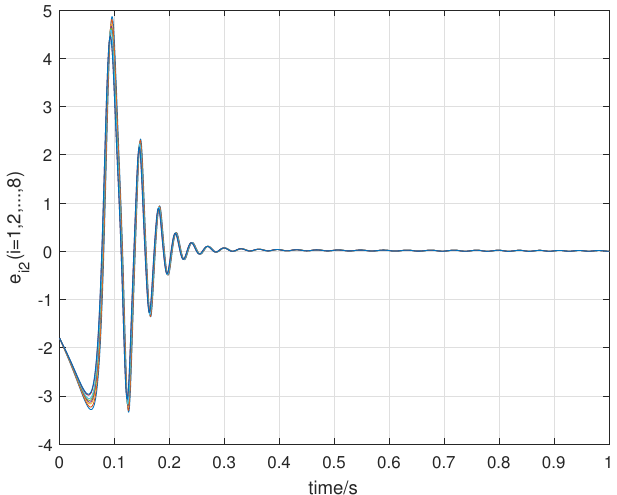
Figure 3. Trajectories of synchronization errors e j 2 ( 1 ≤ j ≤ 8 ) for the complex networks (70) and (73) with eight fractional order nodes with time